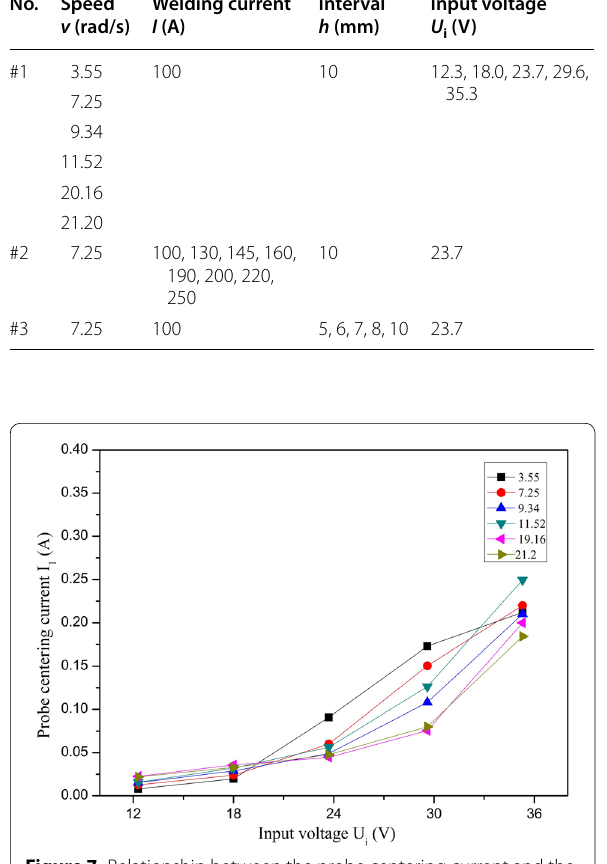
Table 1 Experiment parameters No. Speed Welding current v (rad/s) I (A)